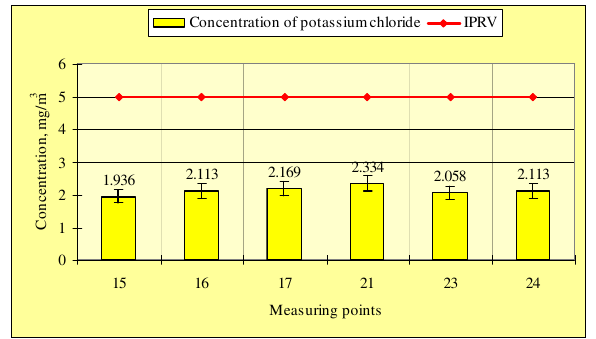
Fig 14 . Distribution of dust concentrations at Terminal of Powdery Manure Discharge in zone III